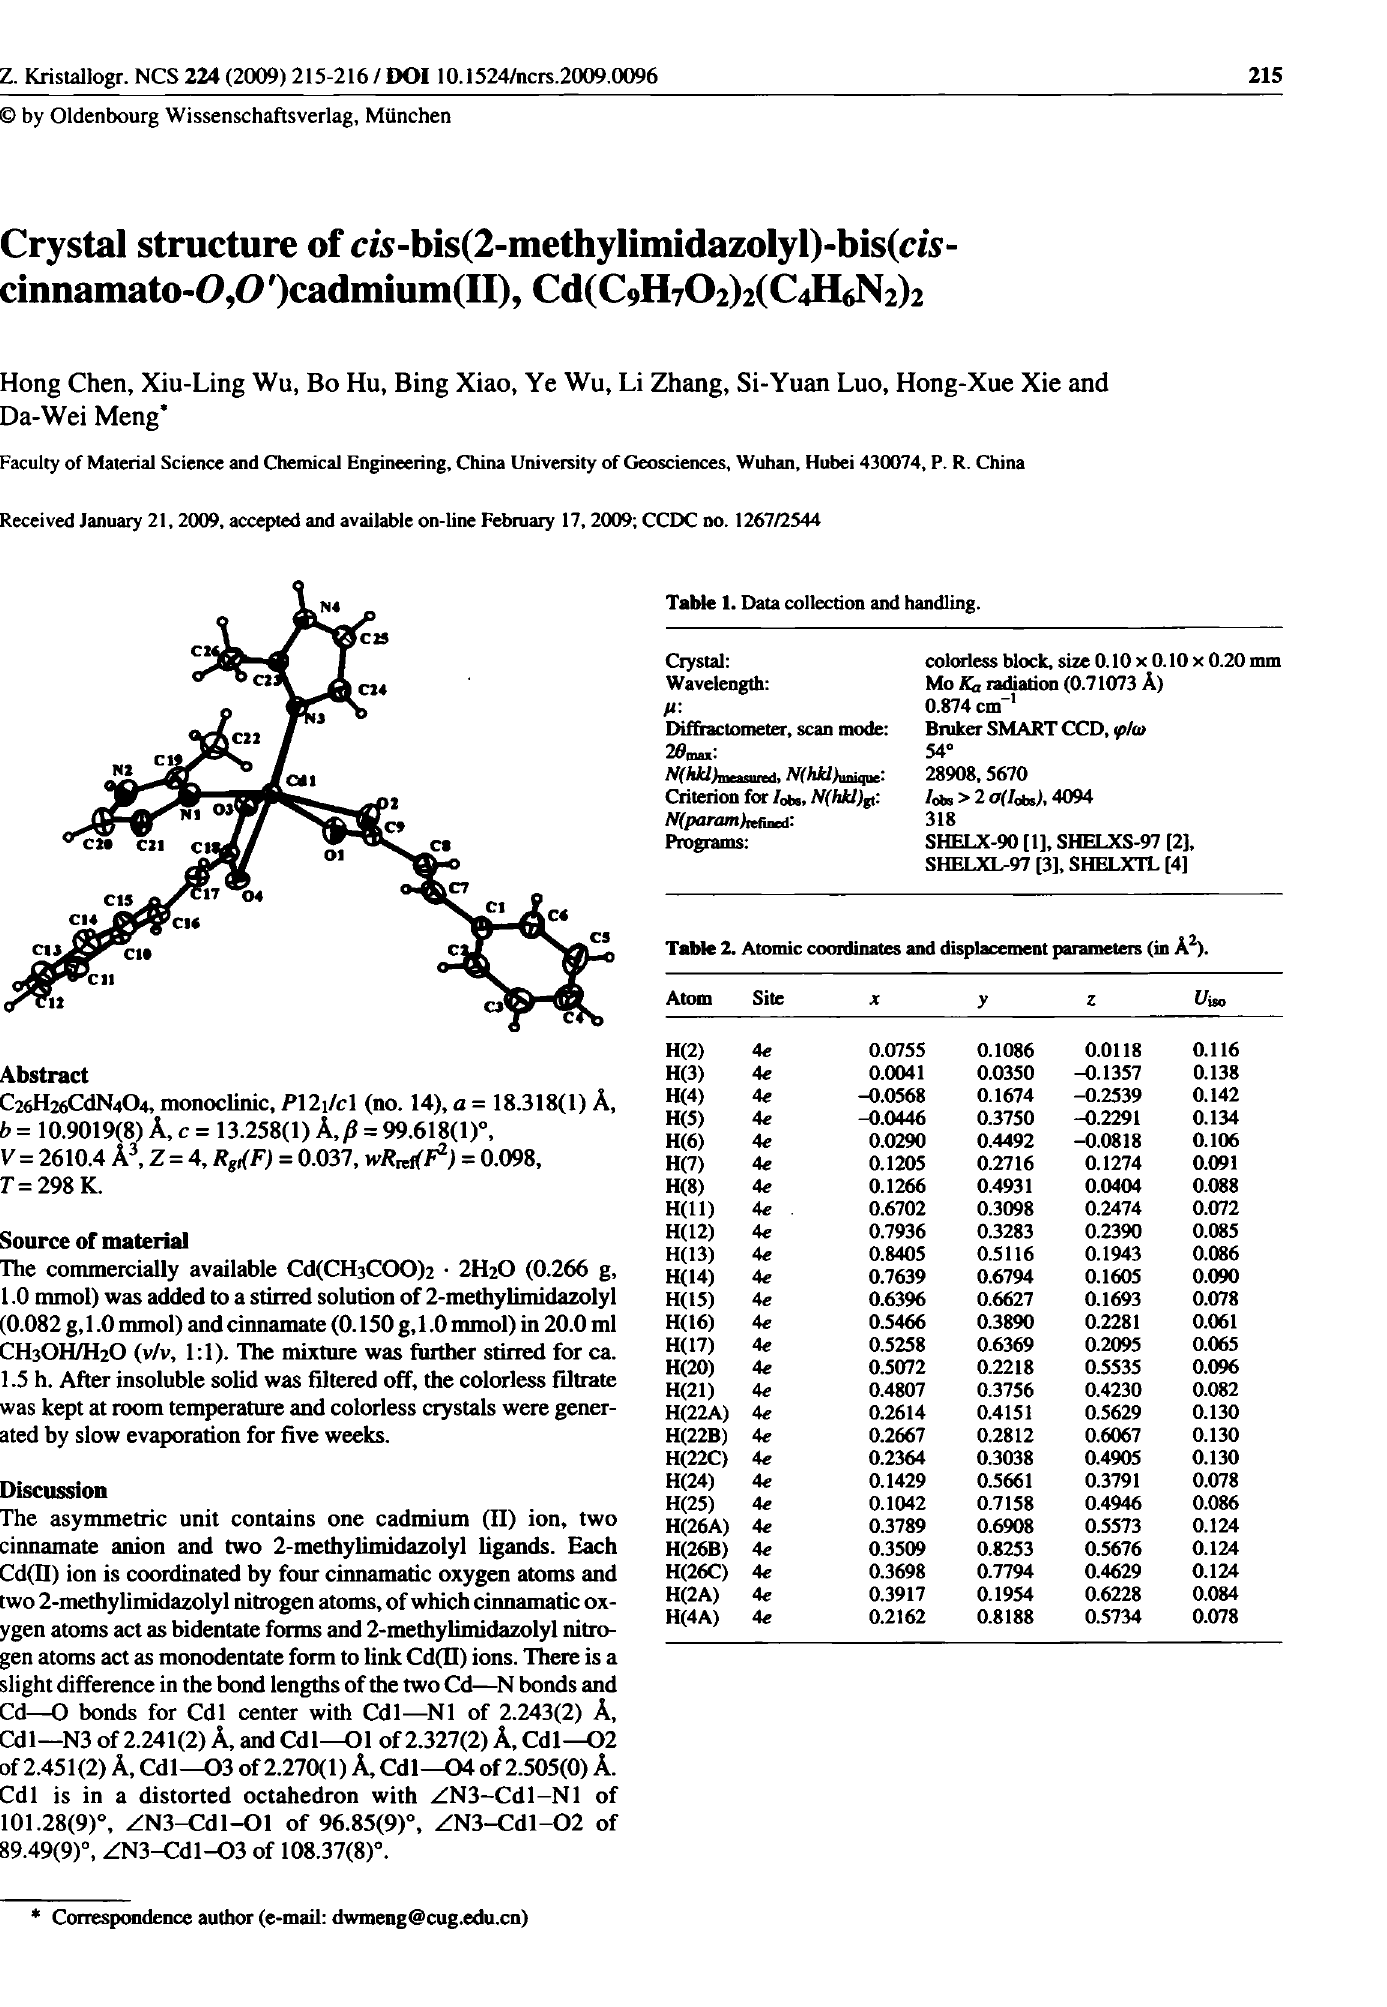
Table i. Data collection and handling. Crystal: